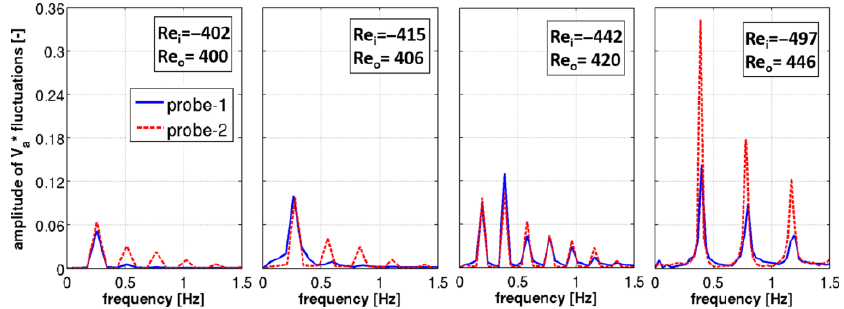
Figure 14. Frequency content of the non-dimensional axial velocity fluctuations for the periodic cases (regime 6).